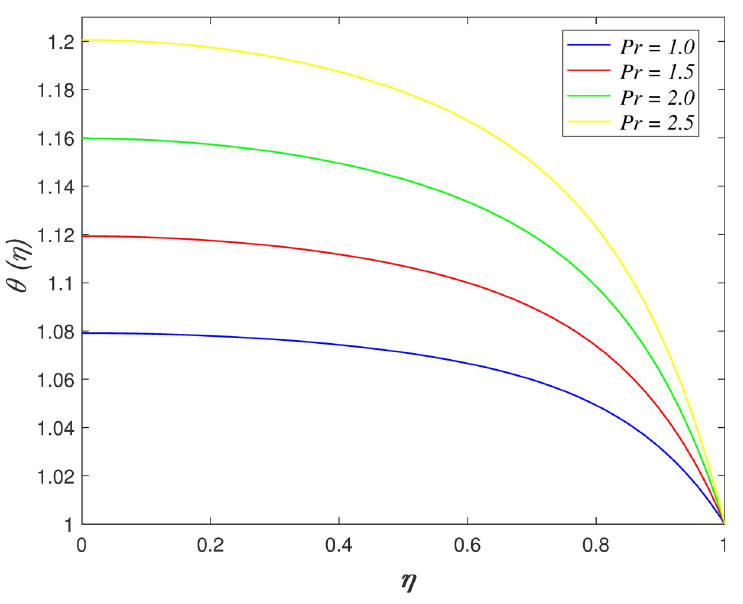
Fig 16. Impact of Pr on temperature.